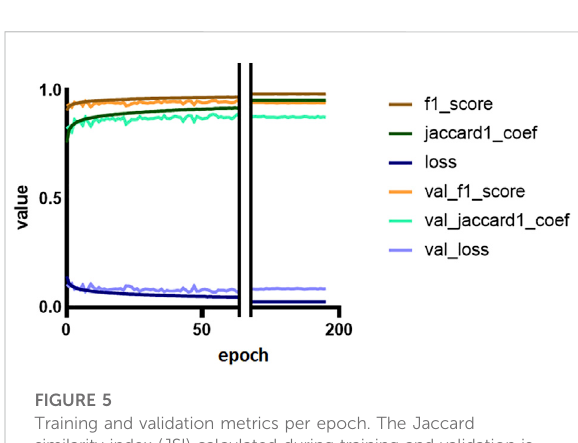
FIGURE 5 Training and validation metrics per epoch. The Jaccard similarity index (JSI) calculated during training and validation is reducedbecauseofamiscon fi guration(seeDiscussionfordetails). The F1 and Jaccard scores for training are overall mean measures of the models ’ precision and recall. Loss is a measure of costs of the model, and represents how poor the model